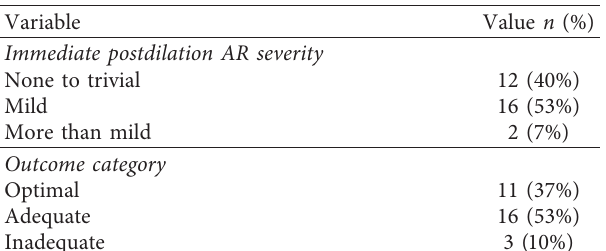
Table 3: Distribution of patients as per aortic regurgitation (AR) severity and outcome category immediately after balloon aortic